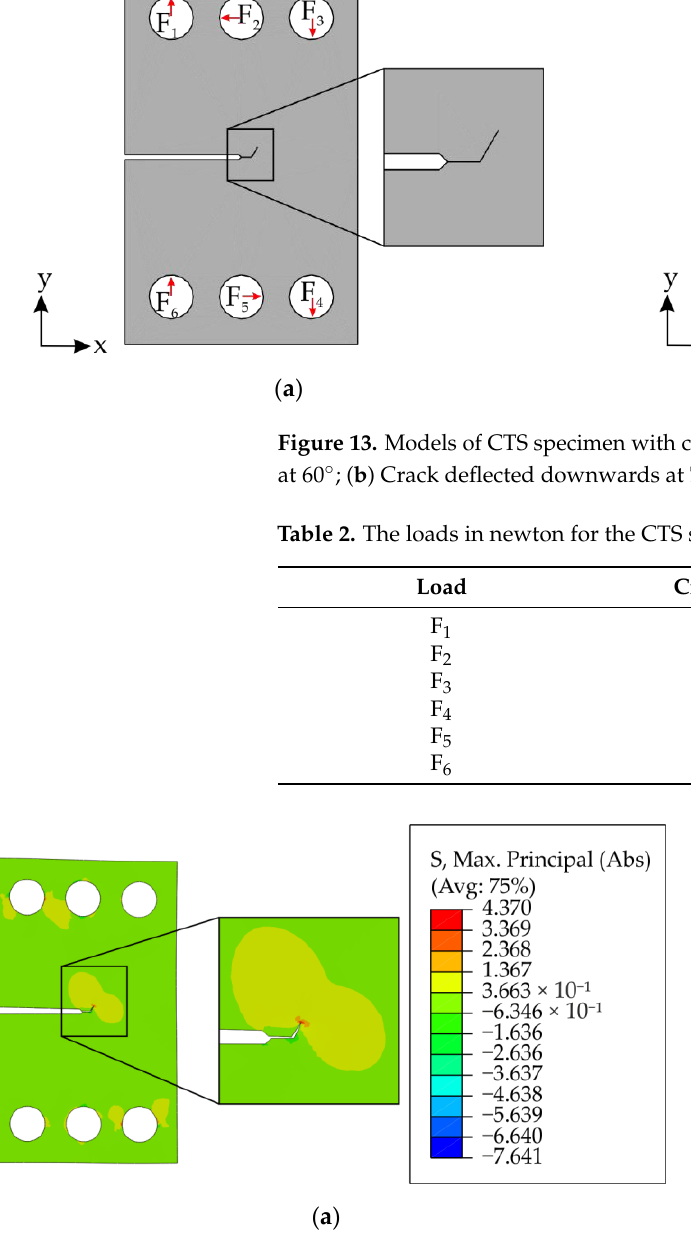
Figure 14. Maximum principal stresses in global models of CTS specimen with deflected cracks: ( a ). Crack with upward deflection of 60° and Mode I loading along the crack surfaces; ( b ) Crack with downward deflection of 70° and Mode I and Mode II loadings along the crack surfaces.